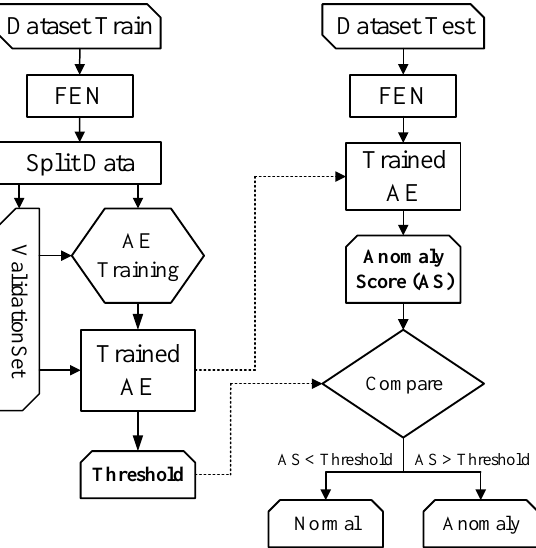
Figure 9. The anomaly detection flow of AutoEncoder model.